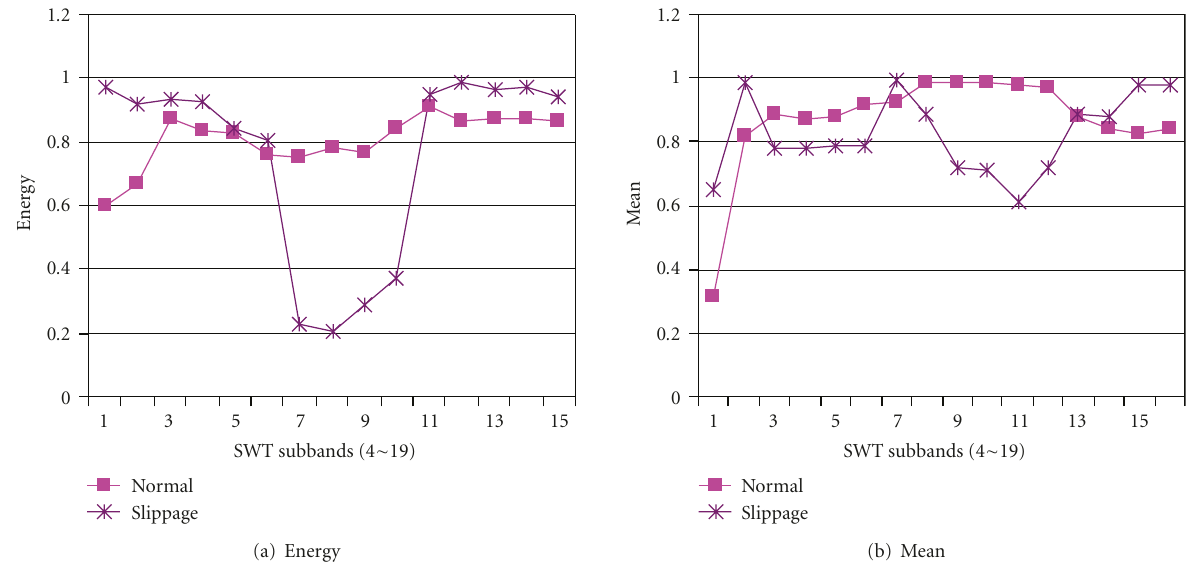
Figure 5: Normalized feature values for Figures 4(b) and 4(f).